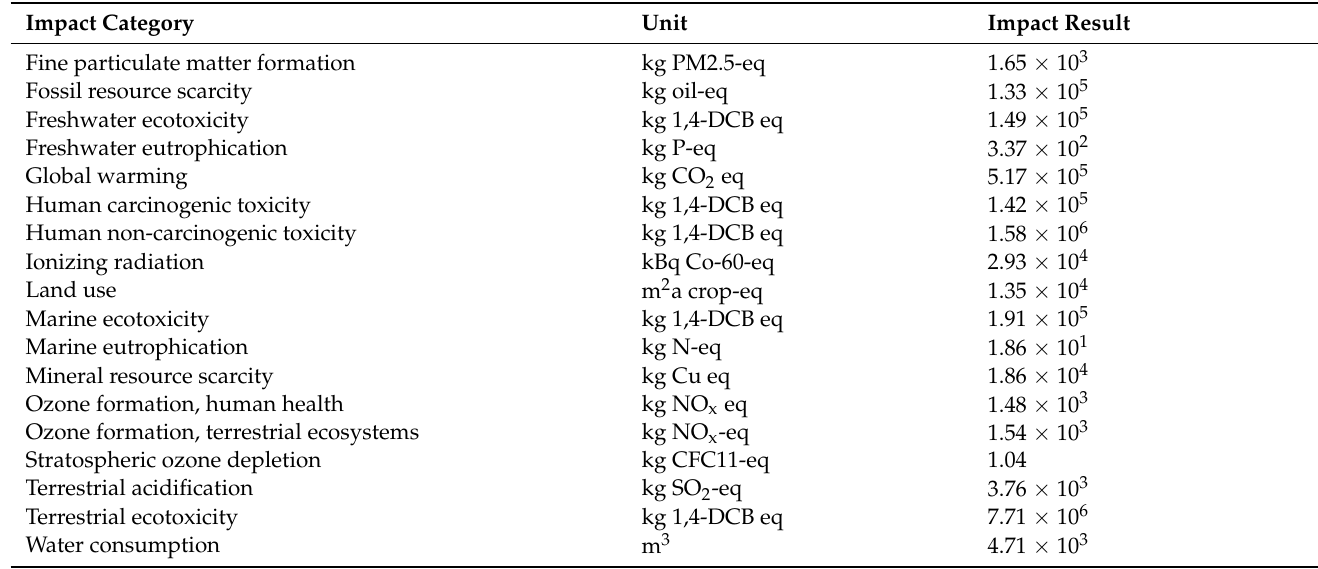
Table 8. The obtained LCA results of the ReCiPe 2016 v1.03 Midpoint (H) impact categories for the suggested design of the 246.02 kWh charging